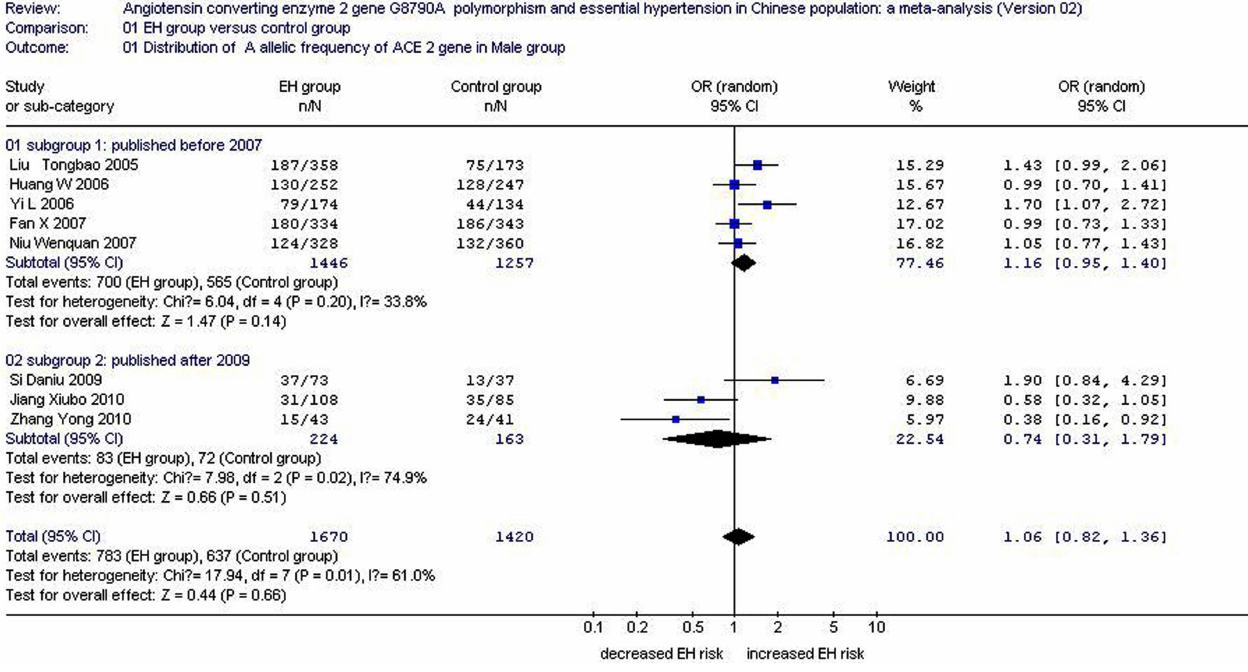
FIGURE 5 | Forest plot of EH associated with ACE2 G8790A gene polymorphism stratified by publication year in male subgroup (distribution ofA allelic frequency of ACE2 gene).